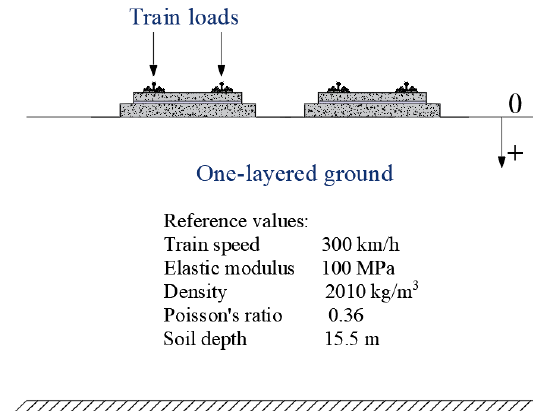
Figure 6. One-layered ground.